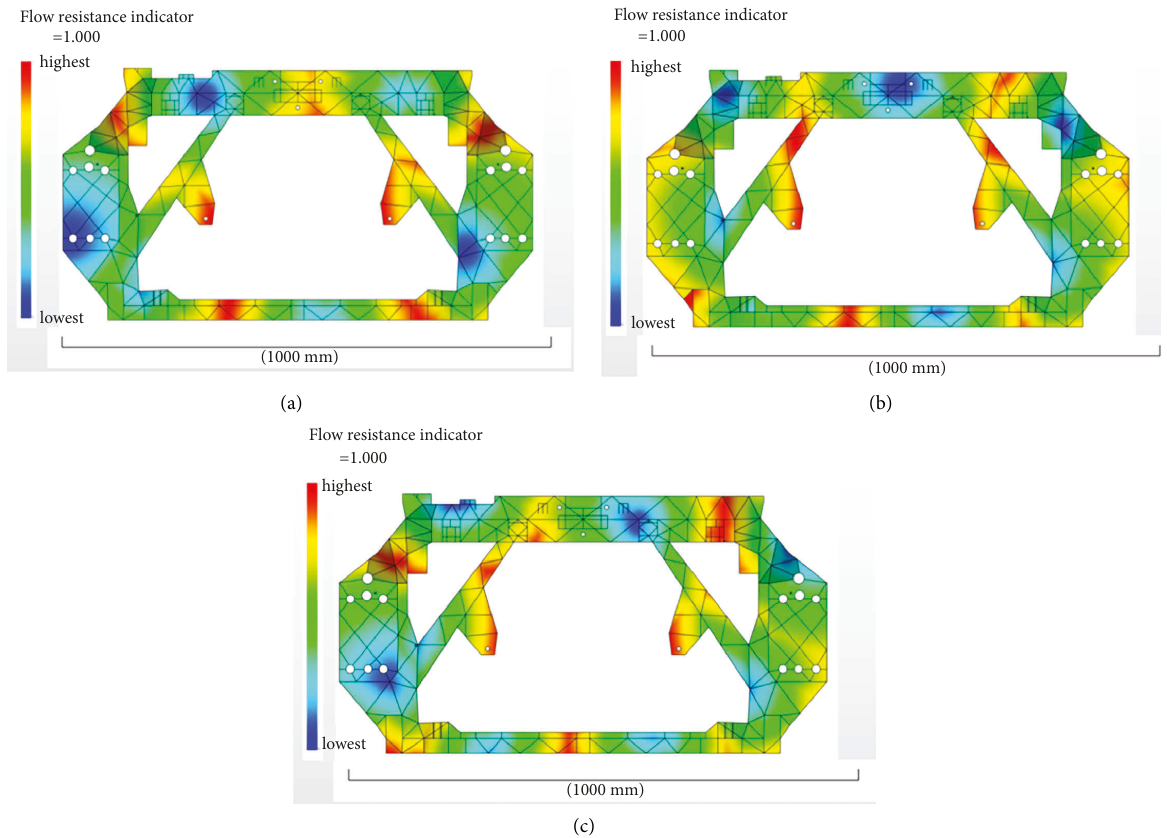
Figure 4: Optimal gate location analysis result diagram. (a) 6 gates location analysis result diagram. (b) 7 gates location analysis result diagram. (c) 8 gates location analysis result Table 1 statistics the analysis information of different numbers of gates in mesh models with different sizes.